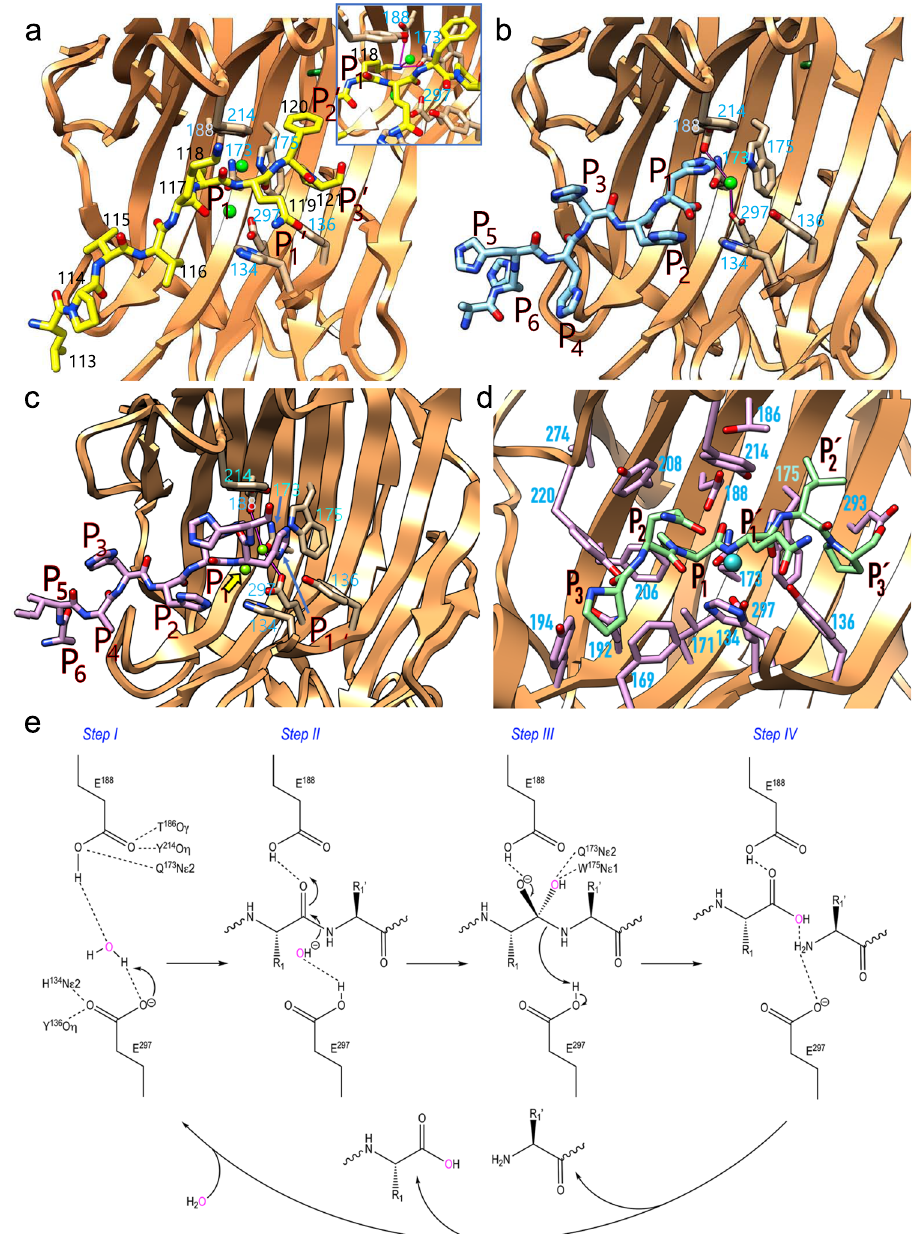
Fig. 6 | The active site and proposed mechanism. a Close-up of Fig. 5c depicting the fi nal segment (L 113 – P 121 ) of the PD de fi ned in the fi nal Fourier map as a stick model with yellow carbons and black residue numbers running across the active- site cleft. The likely P 1 and P 1 ′ – P 3 ′ residues are labelled. In addition, selected resi- dues of the active site are depicted for their side chains with carbons in tan and numbered in light blue. Two solvent residues potentially relevant for catalysis are shown as green spheres. The inset provides a slightly rotated close-up view to highlight the interaction (magenta lines) of K 118 with E 188 , Q 173 and a solvent